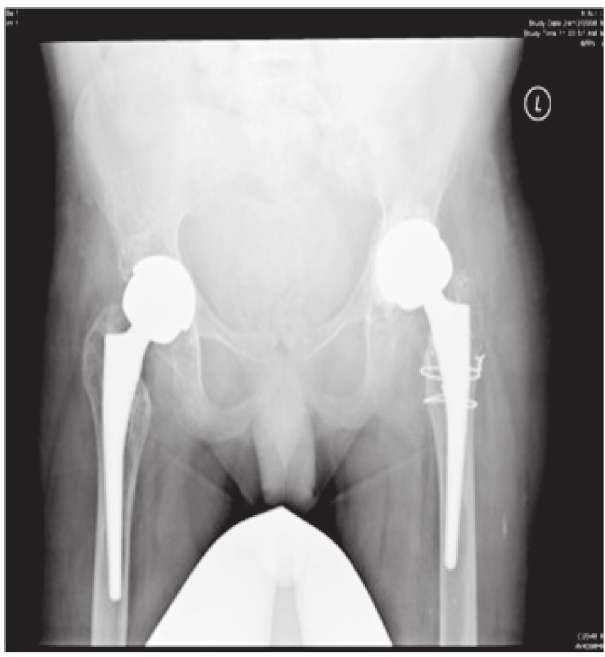
Figure 3. AP pelvis x-ray post bilateral THR.